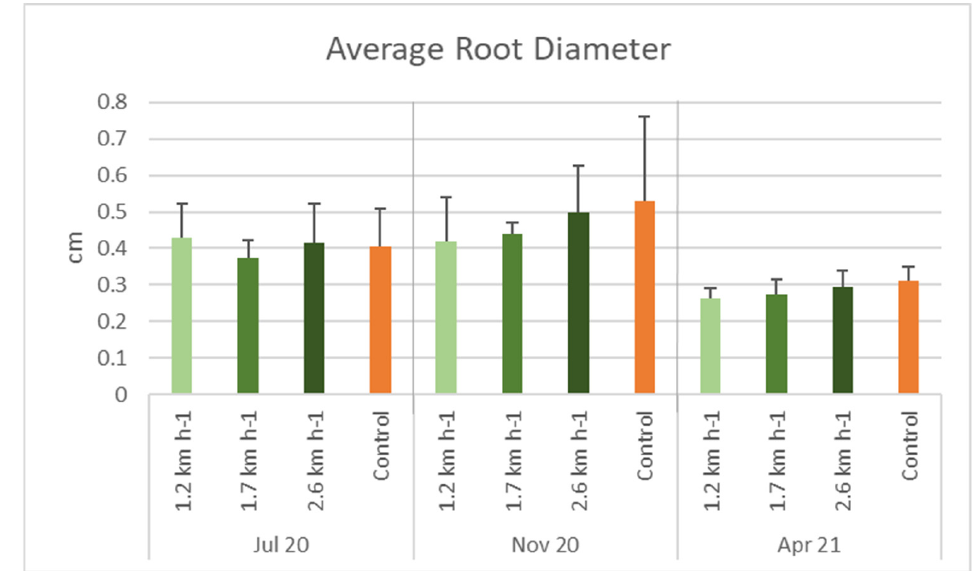
Figure 11. Average root diameter in the three sampling dates and according to the different applied GK treatments. 1.2 km h − 1 , 1.7 km h − 1 and 2.6 km h − 1 indicate the Grass Killer treatments at 1.2, 1.7